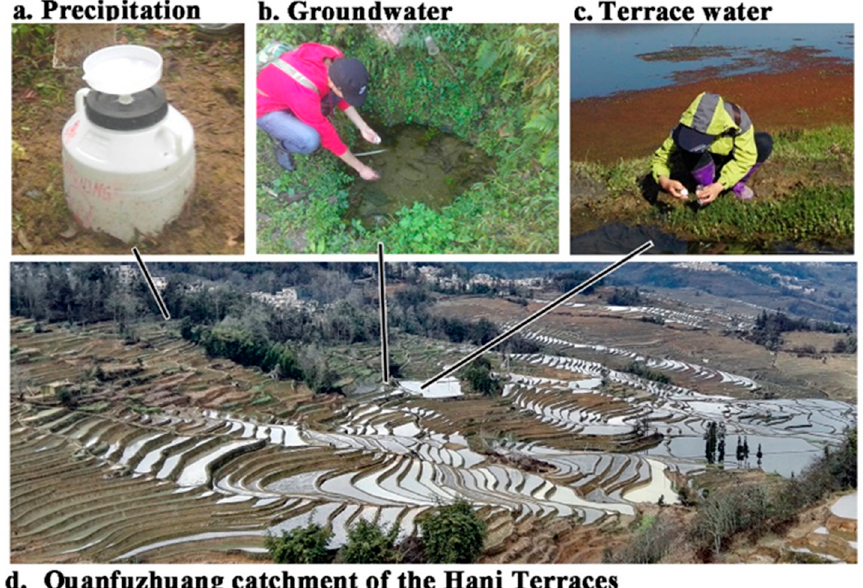
Figure 3. Figures showing the sample collection process in study area: ( a ) precipitation samples collected in Y3, ( b ) groundwater samples collected in D2, ( c ) terrace water samples collected in T2, ( d ) the Quanfuzhuang catchment of the Hani Terraces (part).